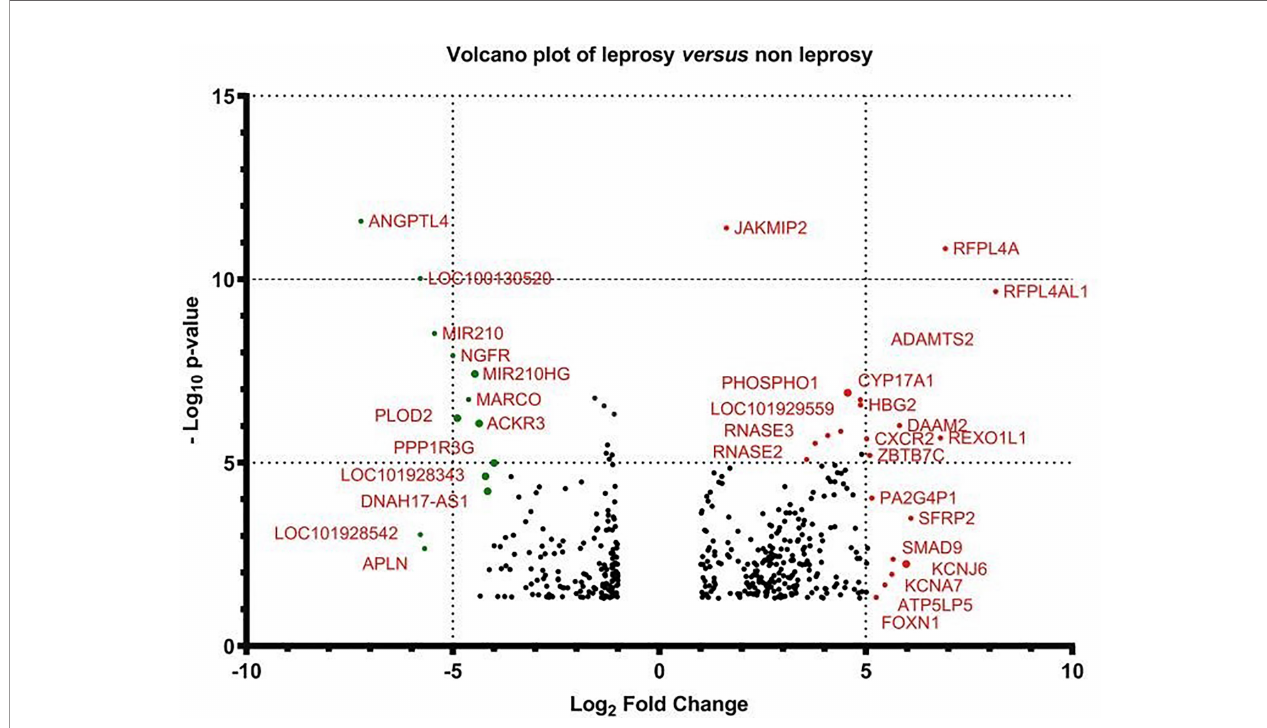
FIGURE 5 | Volcano plot of the gene expression of leprosy patients versus non-leprosy controls. The logarithmic fold changes of individual genes (x-axis) are plotted against the negative log base 10 of their p-value (y-axis). Positive log 2 (fold change) values represent upregulation in leprosy patients compared to non-leprosy controls, whereas negative values represent downregulation. Circles above the dotted line represent differentially expressed genes between leprosy patients and controls with p < 0.05 after correction for multiple testing. Red indicates upregulation and green indicates downregulation of gene